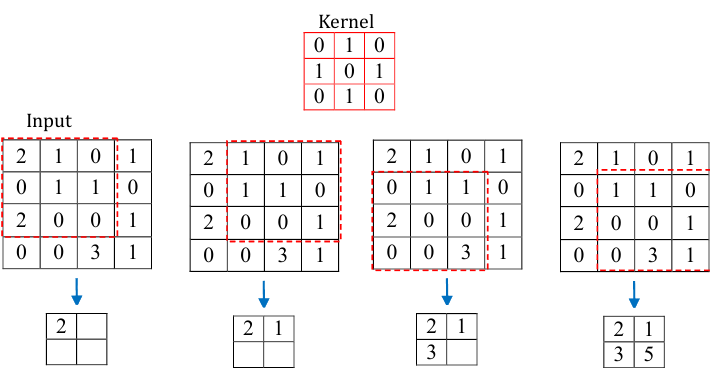
Figure 4. Example of the convolution operation with an input image (4 × 4) and a 3 × 3